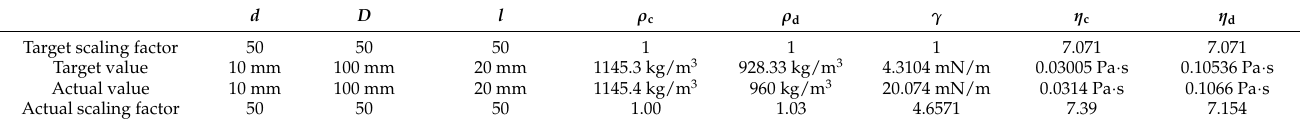
Table 4. Resulting scaling factors, material properties and dimensions of the Ψ = 50 system. d Target scaling